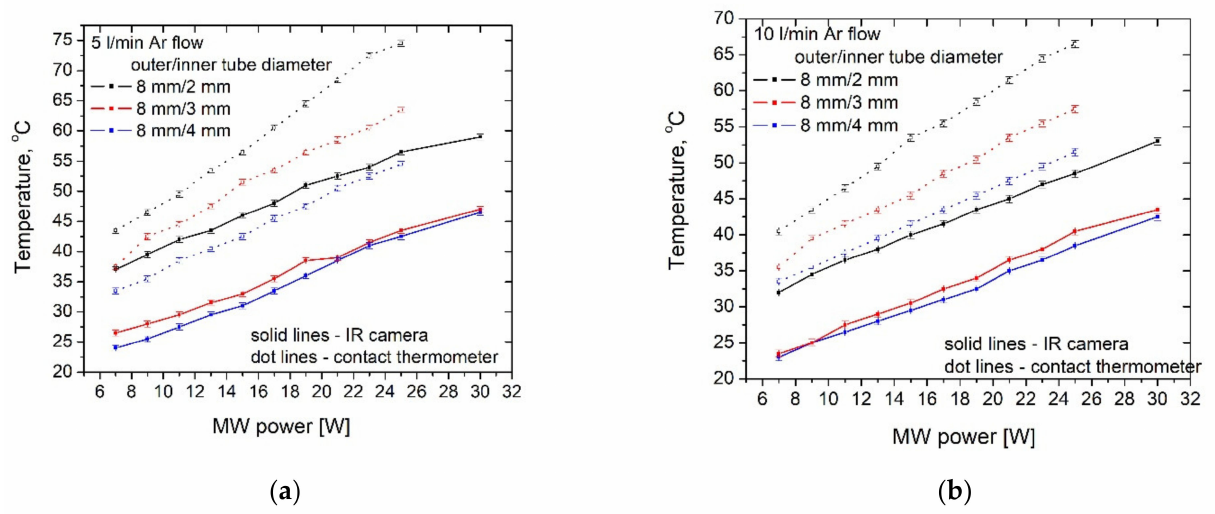
Figure 9. Temperature measured at the position of the sample as function of the wave power for three inner diameters of the discharge tubes. Solid symbols and lines are the results obtained by the IR camera and the empty symbols and dot lines by contact thermometer. The argon flow rate is fixed at ( a ) 5 L/min; ( b ) 10